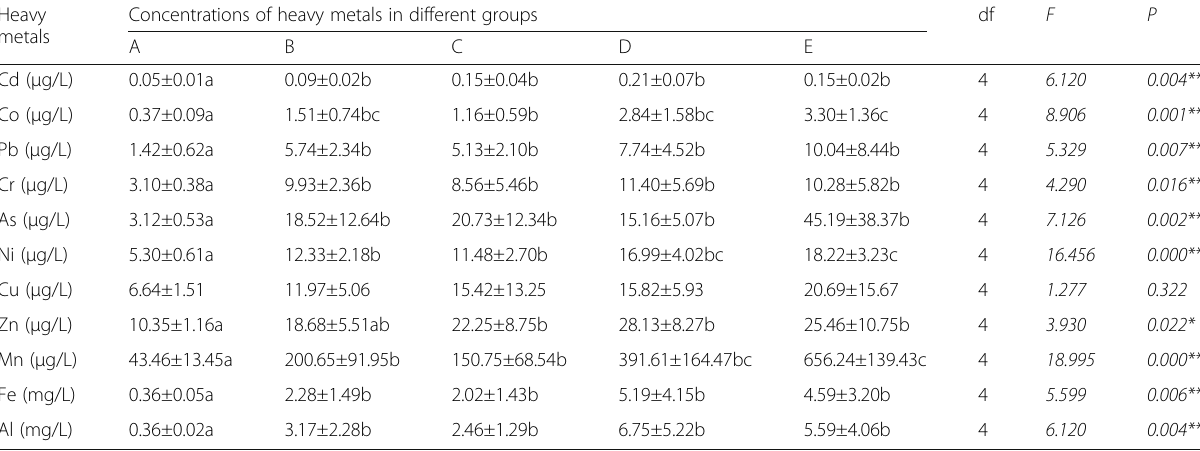
Table 2 Descriptive statistical analysis of 11 heavy metals in water samples of lakes along a rural to urban gradient in central China